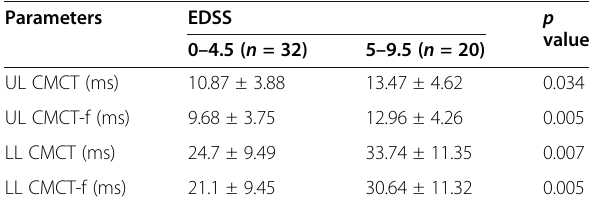
Table 5 CMCT in patients with multiple sclerosis with different